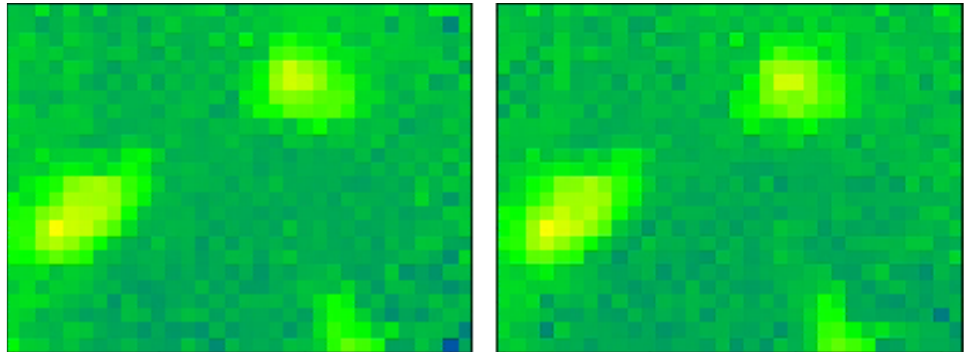
Figure 10. An example of two consecutive frames to show the amount of noise present in them. The total number of people present in the room is 3. However, other than the hotspots which correspond to these people, the other pixels’ values (colors) fluctuate